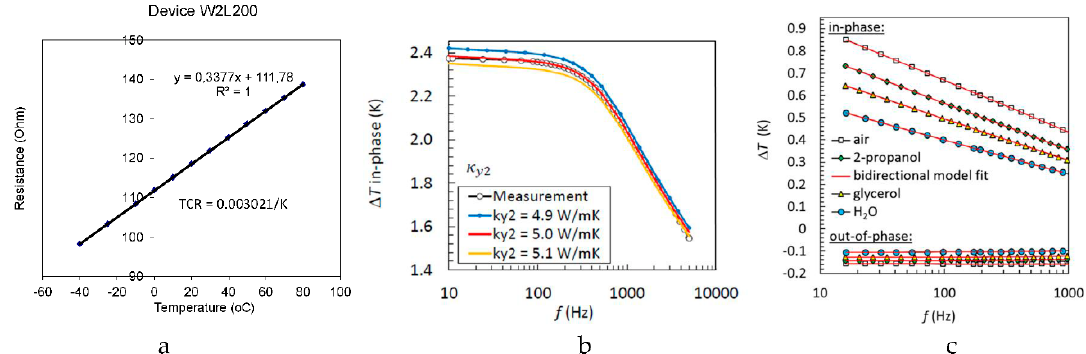
Figure 4. Temperature dependence of resistance of Al heater/sensor on porous silicon layer ( a ), 3 ω measurement results for porous silicon layer, together with fitting curves ( b ), and for 2-propanol, glycerol and water, obtained on TGV glass chip ( c